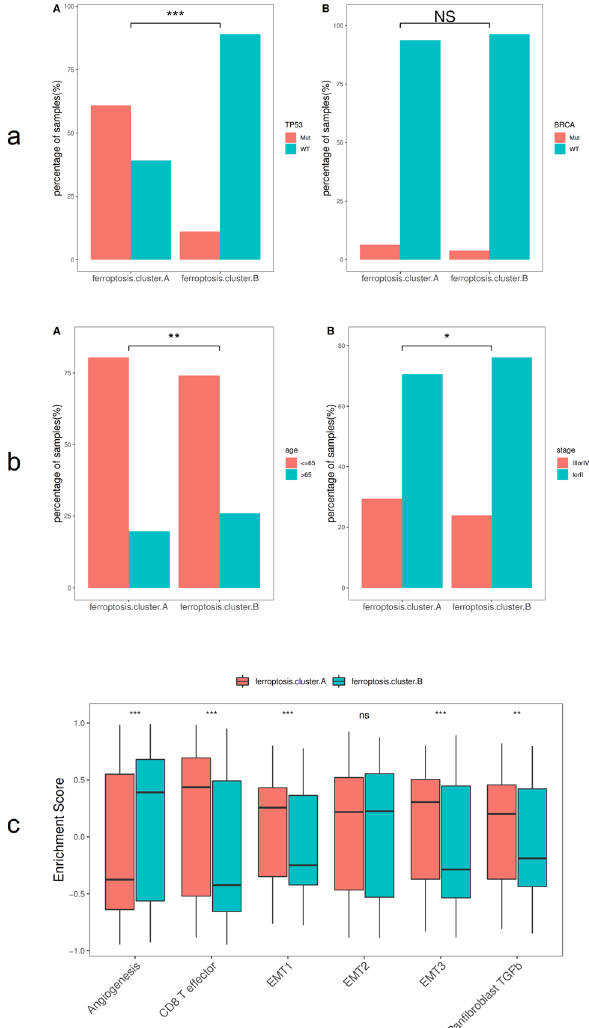
Figure 3. Association analysis between ferroptosis clusters and clinical characteristics. ( a ) Comparative analysis of ferroptosis clusters in the TCGA-BRCA data set (A: TP53 mutation, B: BRCA); ( b ) Comparative analysis of ferroptosis clusters in the TCGA-BRCA dataset (A: age, D: cancer stage); ( c ) Differences in enrichment scores of different ferroptosis clusters, * p < 0:05, ** p < 0:01, and *** p <